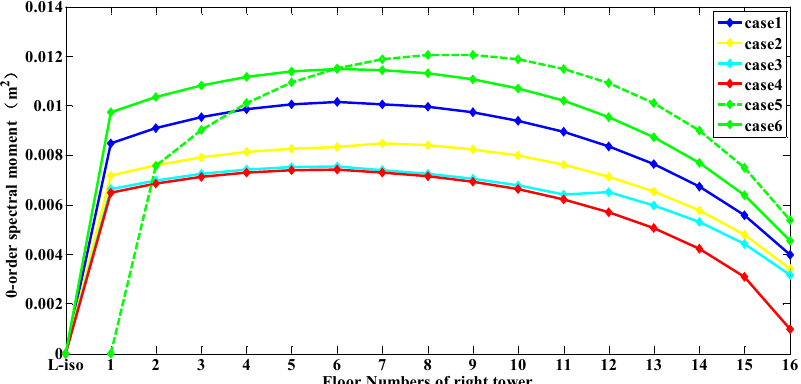
Figure 13. Zero-order spectral moment of the displacement of each layer of the right tower.